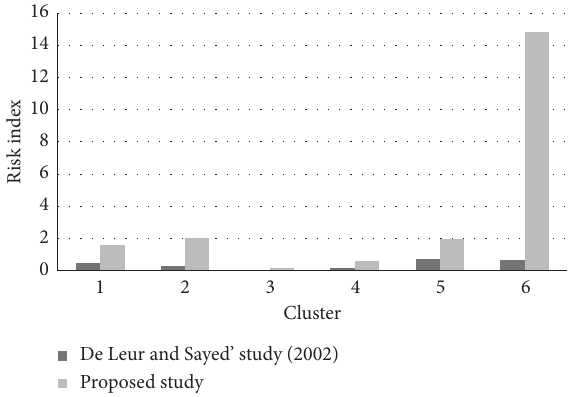
Figure 7: Sensitivity analysis between the two